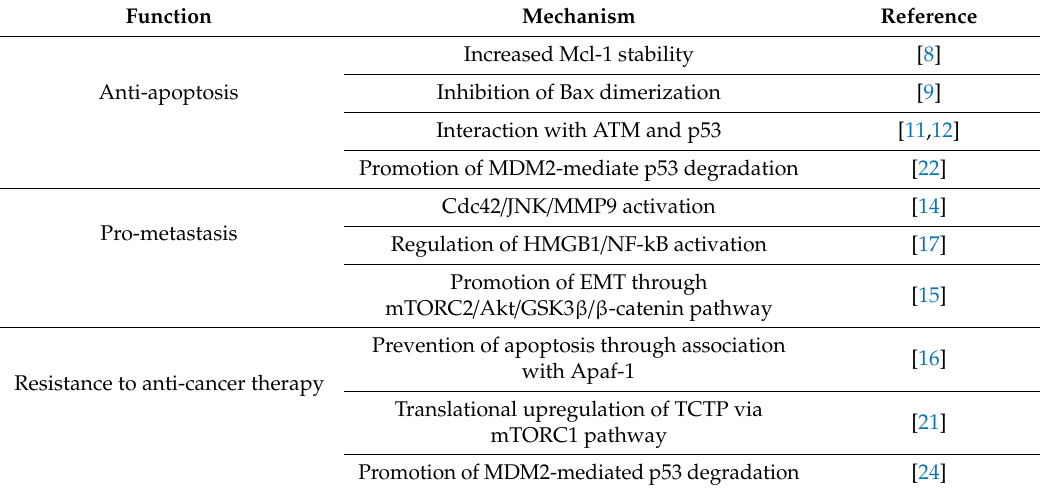
Table 1. Roles of translationally controlled tumor protein (TCTP) in cancer